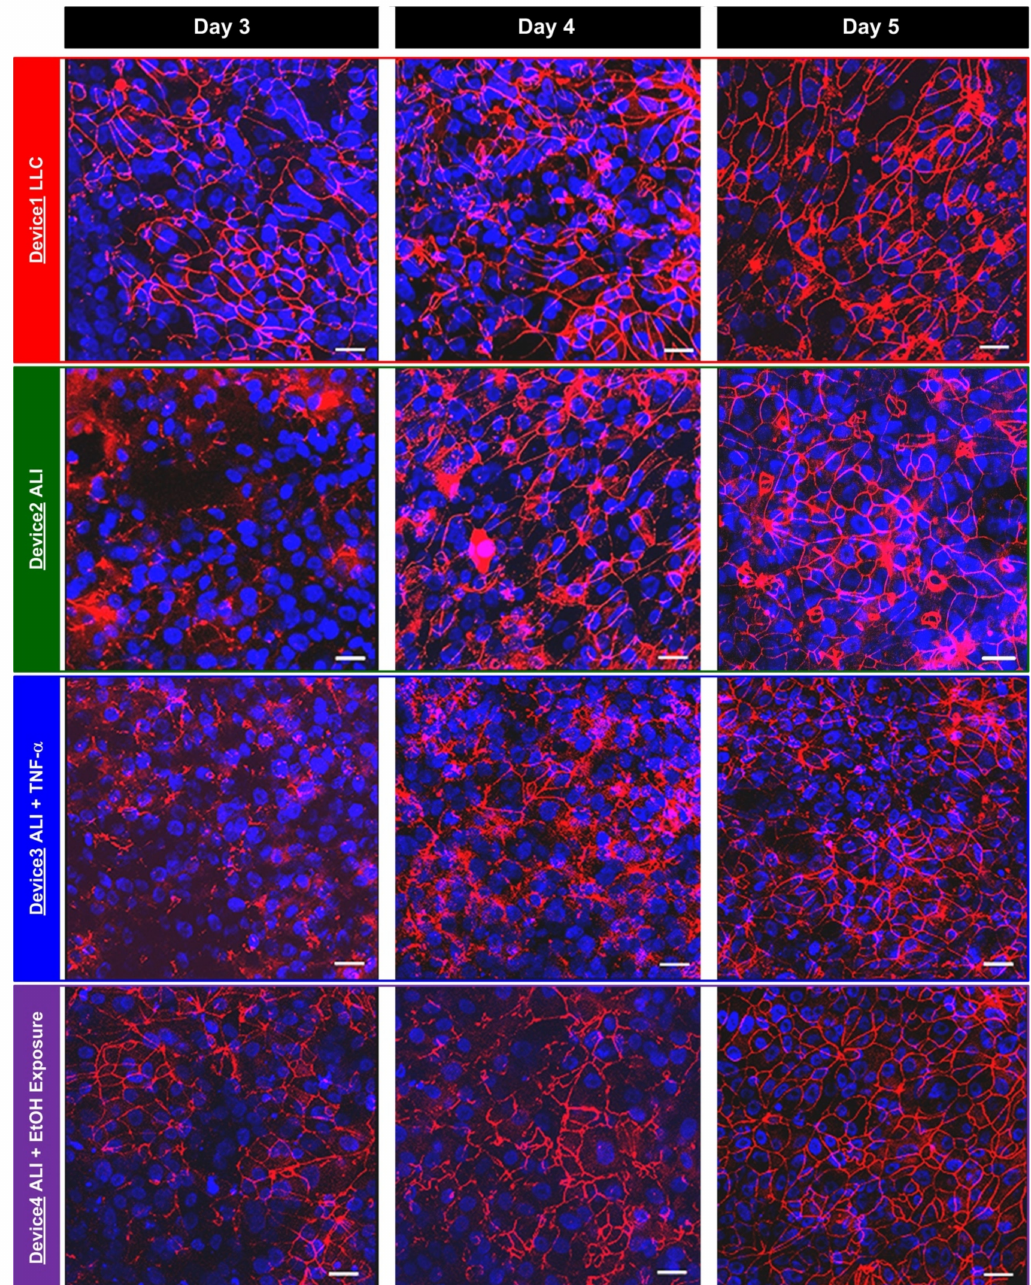
Figure 6. Fluorescence images of the epithelium formed by the hAELVi cells cultured in the devices under various conditions at Day 3, 4 and 5. The cells are stained with tight junction protein ZO-1 (red) and nuclei (blue). Scale bar is 20 µ